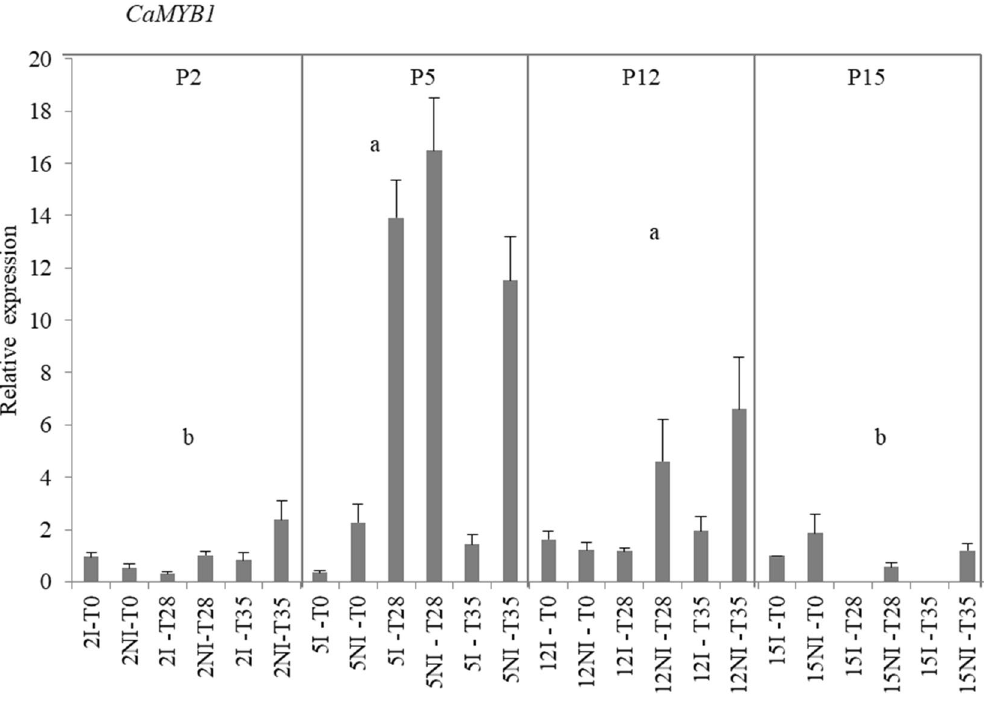
Figure 4. Gene expression profile under irrigated (I) and non-irrigated (NI) conditions. Gene expression of the CaMYB1 gene was analyzed on leaves of coffee progenies 2, 5, 12 and 15. Abundance of transcripts was normalized using CaUBQ10 gene expression as an endogenous control. The results were expressed using 15 I as the reference sample (Relative Expression = 1). Values of three replicates were presented as means ± SE (bars). Ranked results of the relative expression data of the progenies were analyzed using the non-parametric Kruskal– Wallis test followed by a pairwise comparison with the Mann–Whitney test. Significance level were established as p-values < 0.05, for both tests. Progeny patterns of relative expression values followed by the same lowercase letter do not differ statistically from each